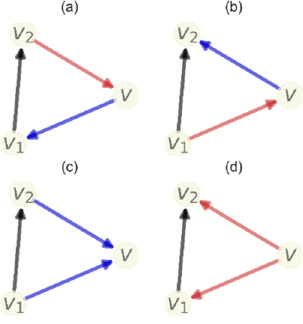
Figure 6. Four archetypical triangles in a directed network. For a directed edge from (cid:1874) (cid:2869) to (cid:1874) (cid:2870) , col- ored in black, the incoming edges are colored in blue and the outgoing edges are colored in red. Type ( a ) represents a backward loop that contributes positively to the curvature. Type ( b ) represents rection, we do not take them into account in our